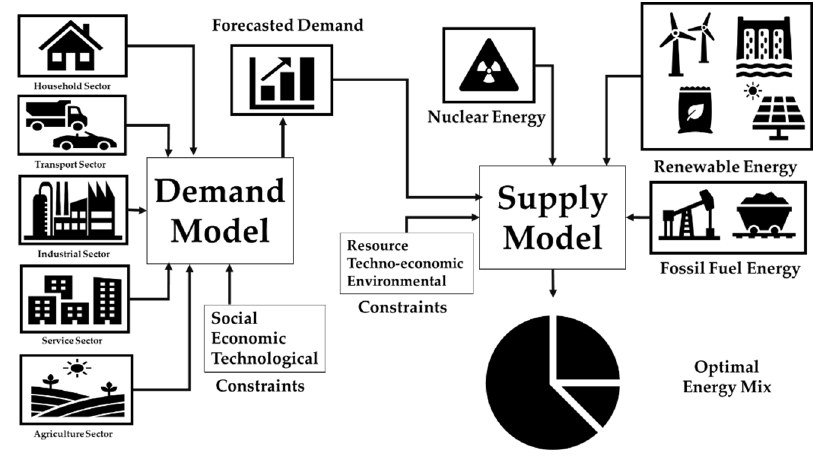
Figure 2. The overall concept of an integrated energy model for Pakistan.